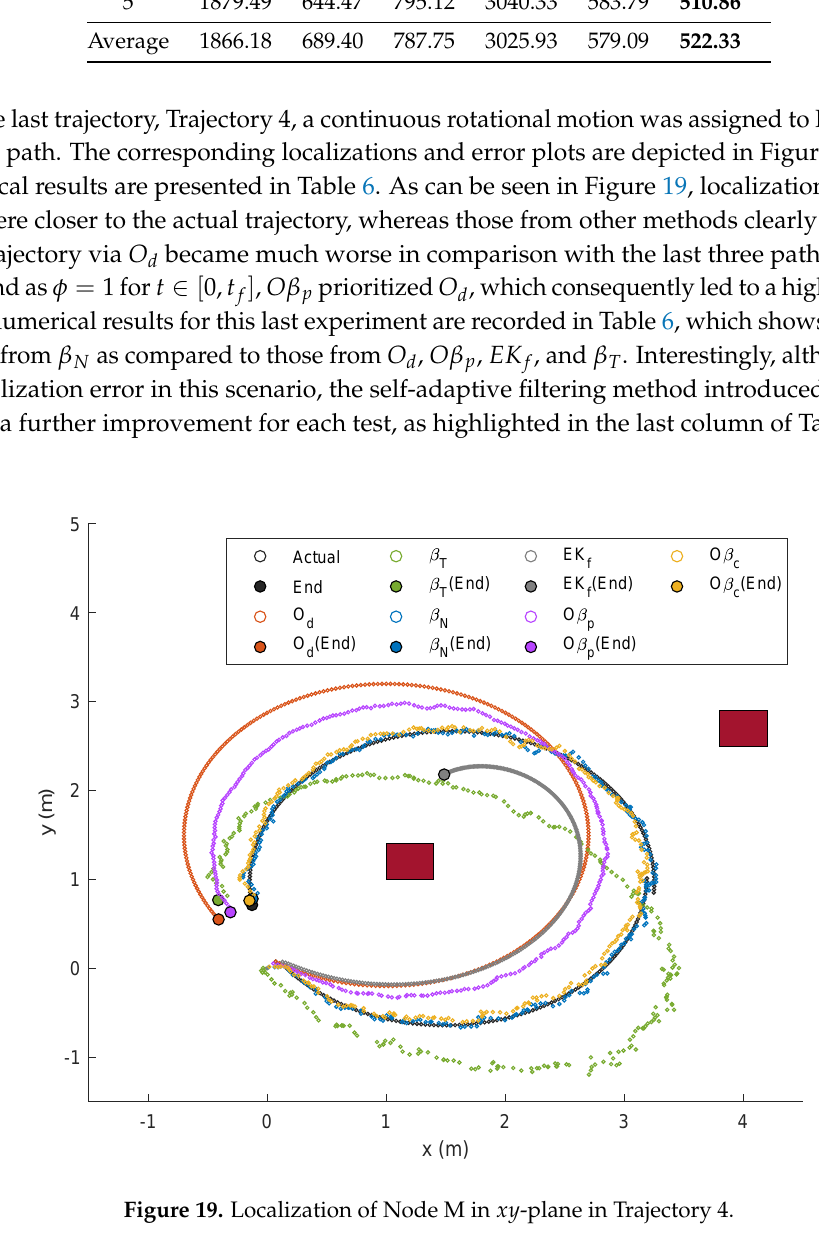
Figure 19. Localization of Node M in xy -plane in Trajectory